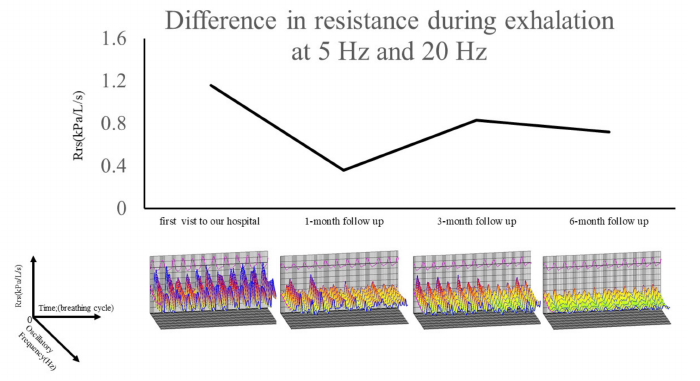
Figure 3. Changes of R5-R20 (Ex) and colored three-dimensional images of respiratory cycle depen- dence (Rrs was higher and Xrs was more negative in the expiratory phases than in the inspiratory phases) and frequency dependence (Rrs increased at lower frequencies and fell with increasing frequencies) over a 6-month period. R5-R20 (Ex), difference in resistance during exhalation at 5 Hz and 20 Hz; Rrs, respiratory system resistance; Xrs, respiratory system